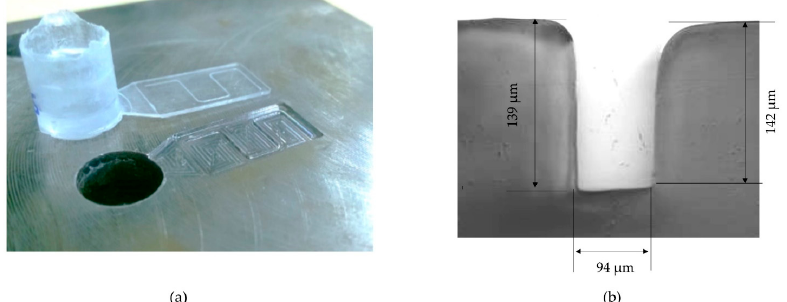
Figure 10. Preliminary micro-fluidic plate of polystyrene fabricated in Ferrer et al. ( a ) Micro-fluidic plate of polystyrene; ( b ) Micro-channel dimensions.